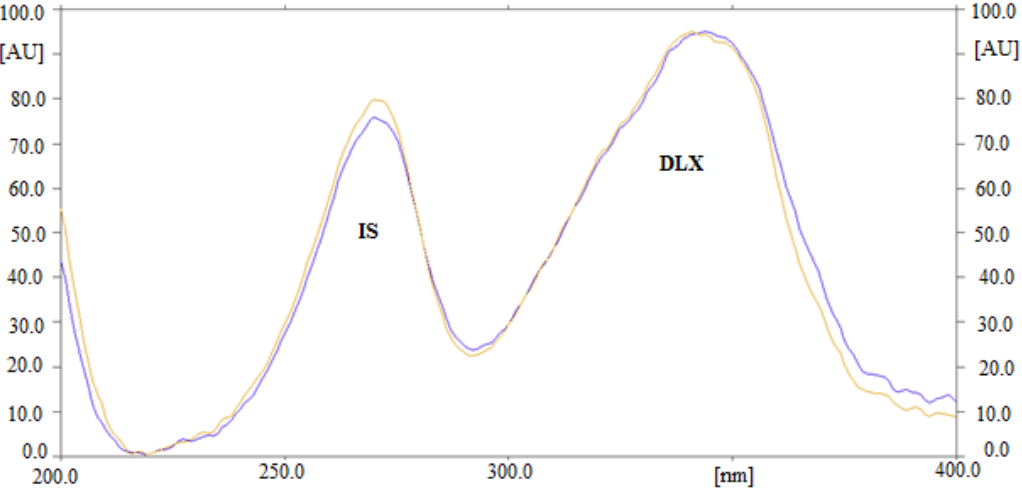
Figure 1. Overlaid UV absorption spectra of Delafloxacin (DLX) and internal standard (IS).